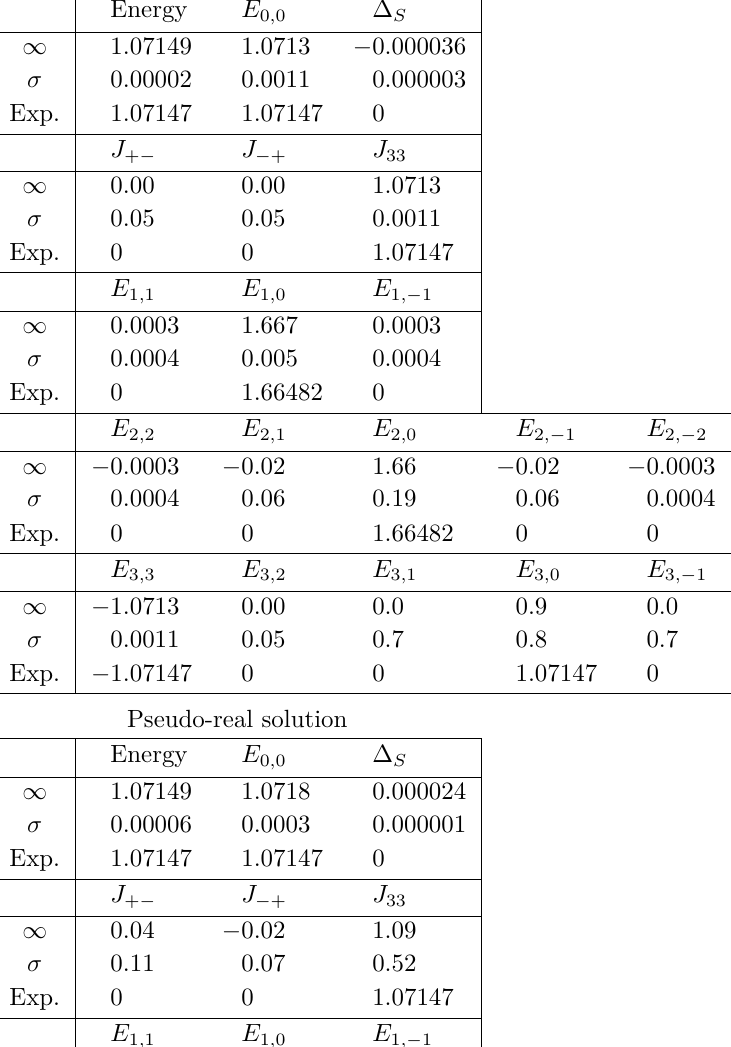
with half-integer j are identically equal to j,m